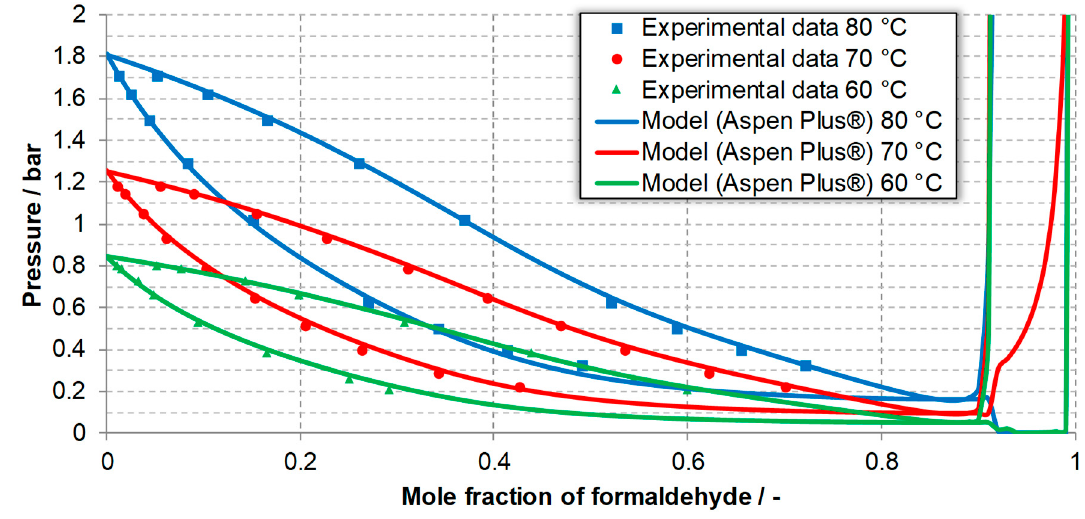
Figure 8. Phase equilibrium of the FA-MeOH system for different temperatures calculated using Aspen Plus ® , compared to the experimental data [65].